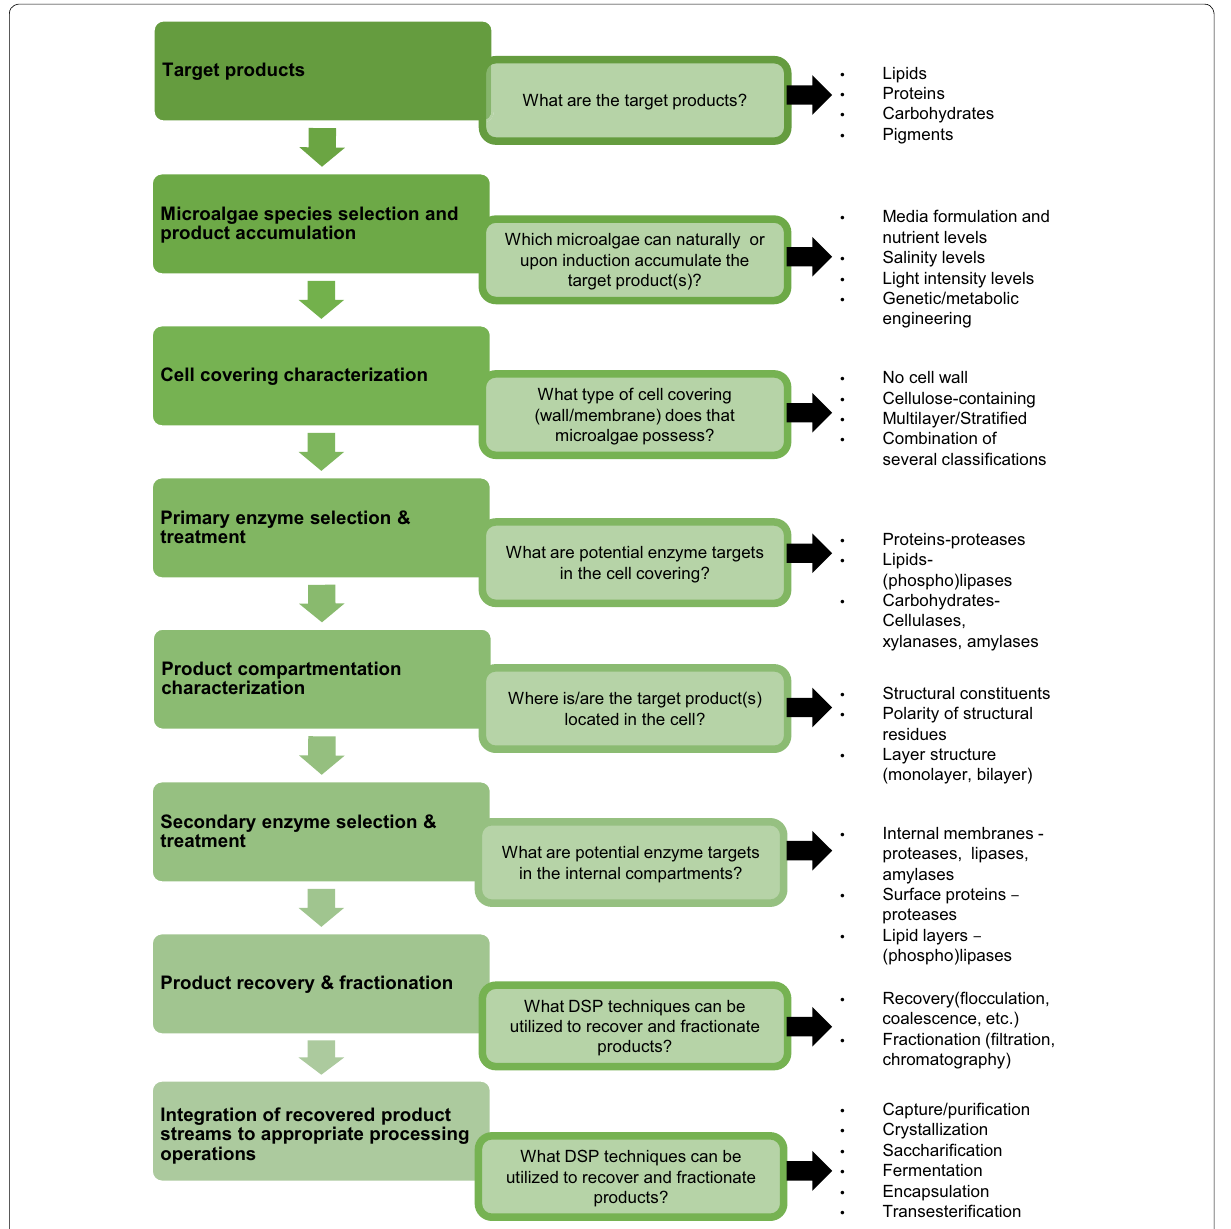
Fig. 3 Aqueous enzymatic processing scheme workflow and design